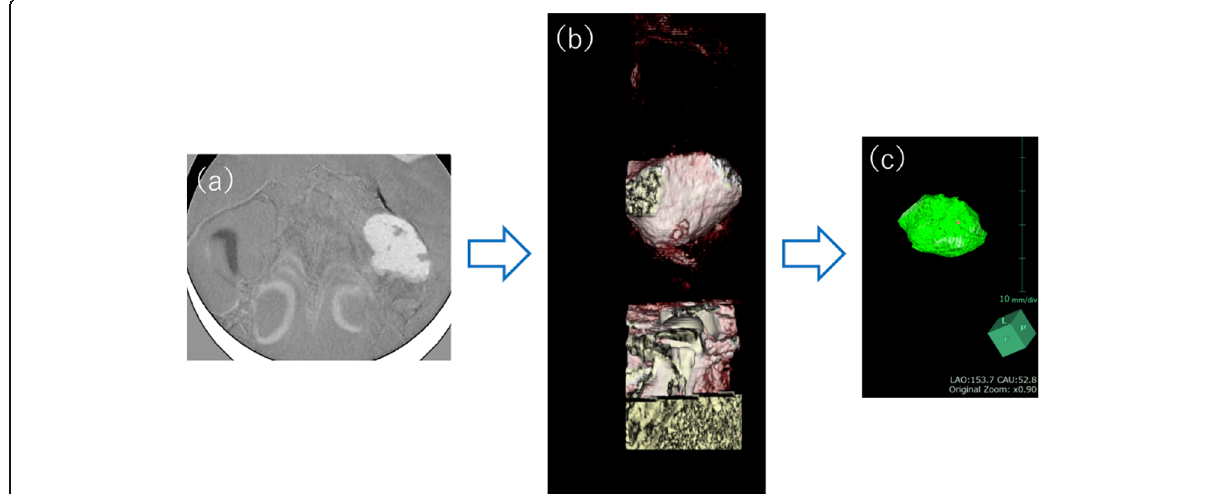
Fig. 4 The overlaid images were trimmed, and the volume was measured using “ overall measurements. ” Image obtained after a “ image reconstruction, ” b trimming on the vertical axis, and c trimming of unnecessary data (information)